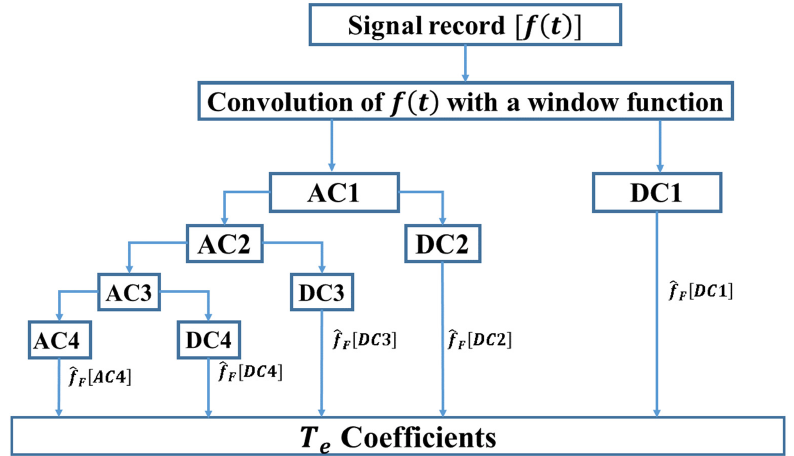
Figure 1. Decomposition tree of the dyadic Te-transform, AC are the approximation coefficients, and DC are the detail coefficients.